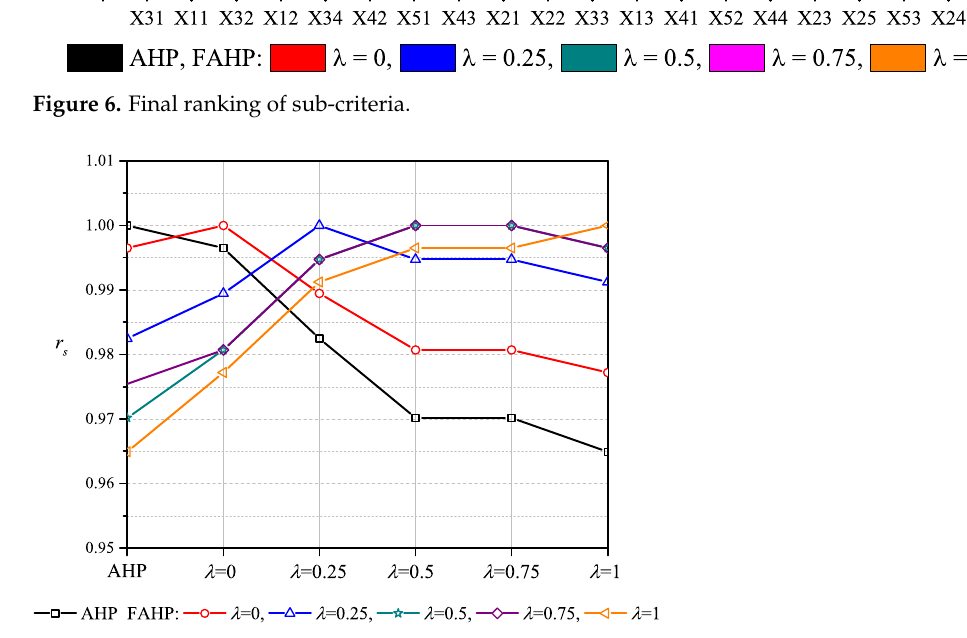
Figure 7. Ranking